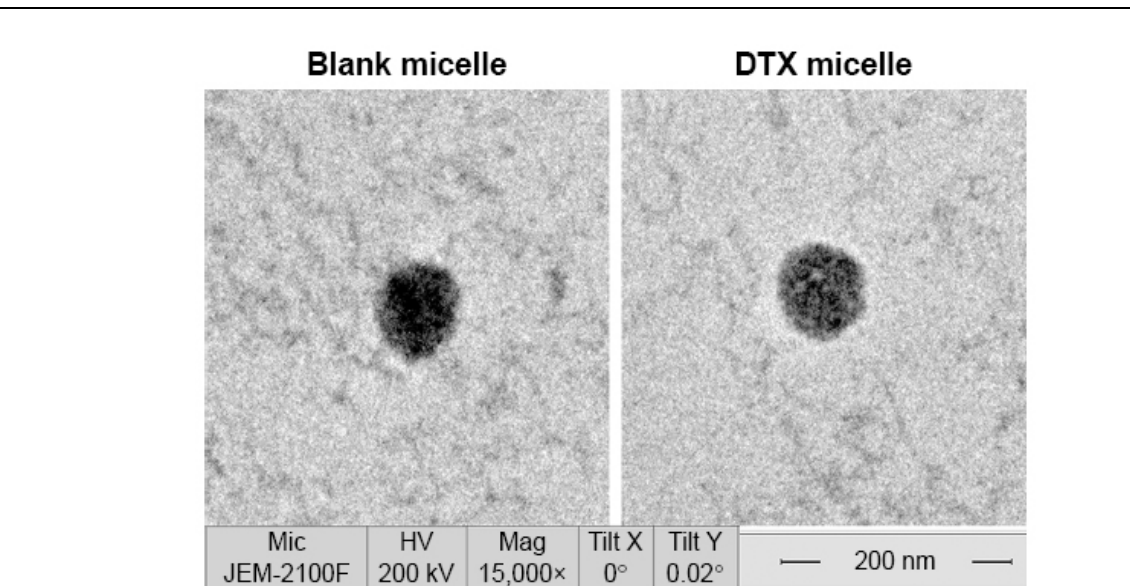
Figure 1. TEM image of blank micelles and doxorubicin (DTX)-loaded PM. The PM composition consists of poly(ethylene glycol)-poly(caprolactone) (PEG-PCL) (molecular weight: 3900 Da) with a two-block ratio of 1:1. Reproduced from [40] “International Journal of Nanomedicine 2018:13 5971–5990’ Originally published by and used with permission from Dove Medical Press Ltd.”. The position of the drug molecules within the PM is based on both the properties of the drug and the length of the polymer chain in the amphiphiles. Normally, a strongly hydrophobic drug is located within the PM core, which is hydrophobic, while drugs with intermediate polarity or high hydrophobicity will be present between the core and the surface or on the surface of the PM [32]. The interaction of drugs with the polymer may be due to simple electrostatic interactions or may arise due to covalent bonding. This results in different capacities of drug loading or encapsulation in the micelles [32,37]. As